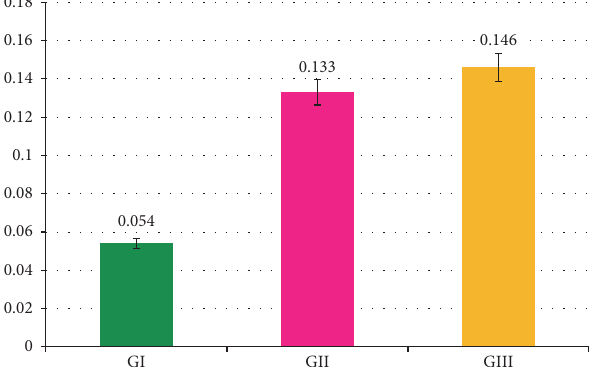
F IGURE 4: Bar graph showing the mean dye leakage value across